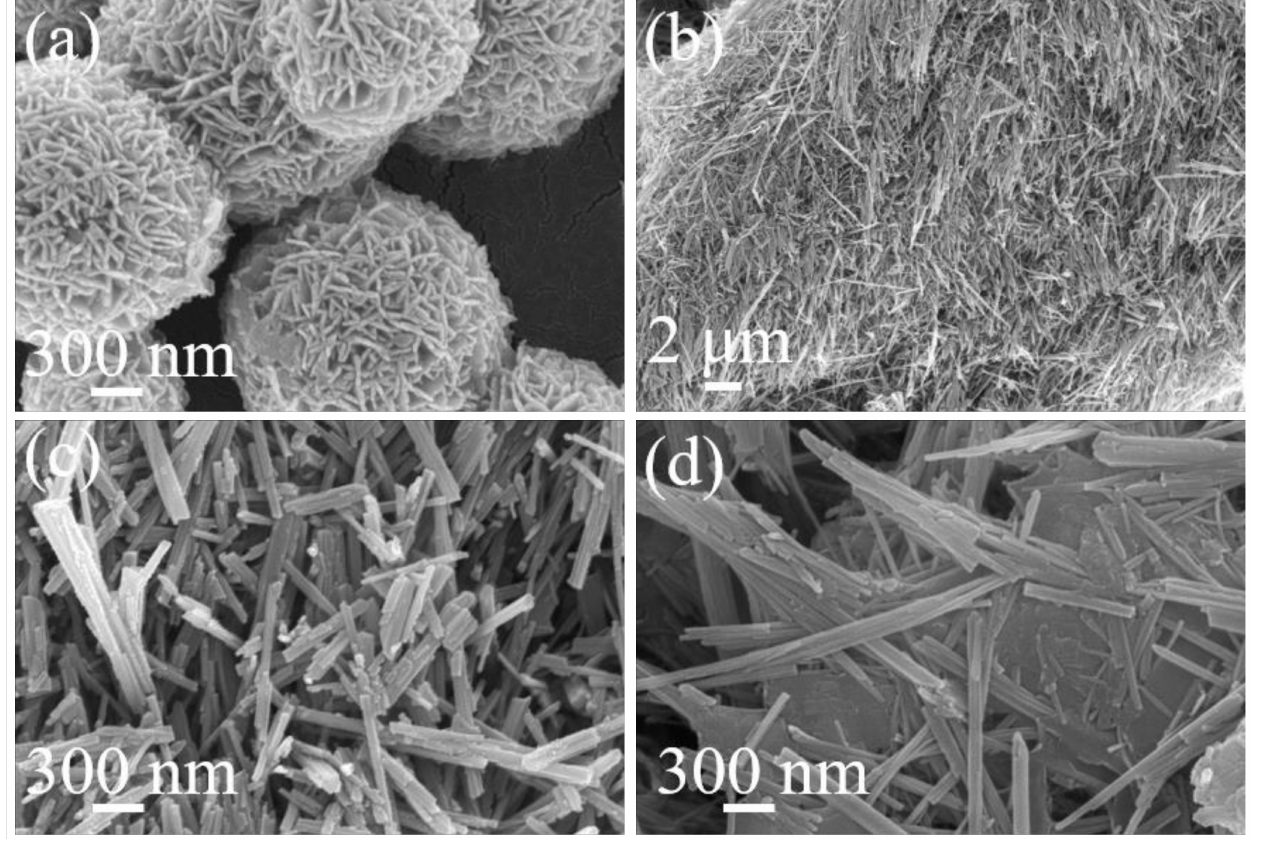
Figure 1. SEM images of as-prepared samples: ( a ) pure BiOI; ( b , c ) pure α -MnO 2 ; and ( d ) MBI2